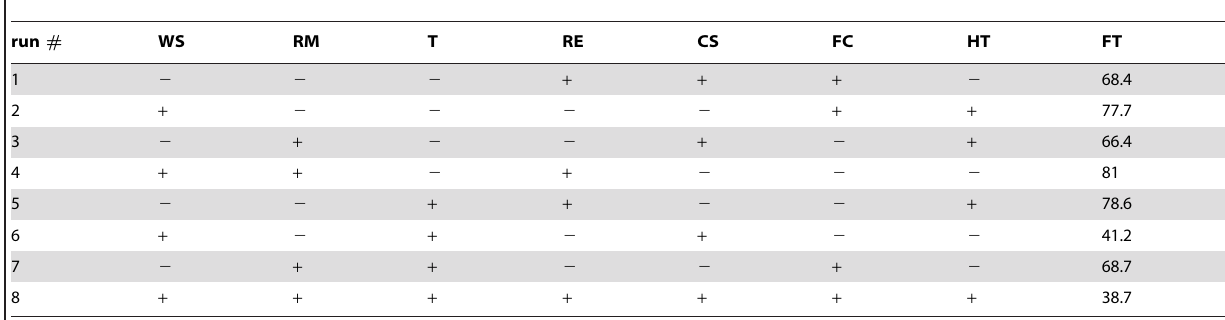
Table 2. The 2 III7-4 screening design for filtration rate data [11].